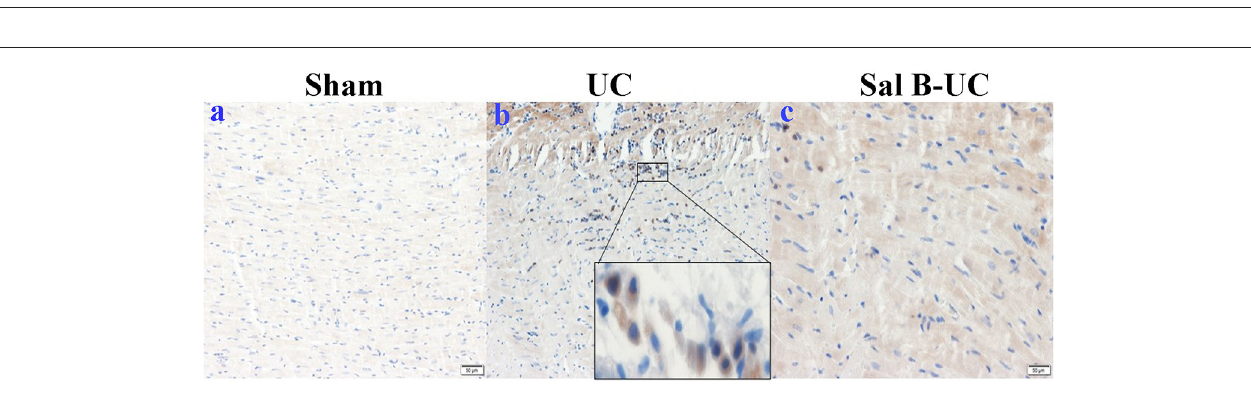
FIGURE 5 | Immunohistochemical (IHC) staining of CD3. The IHC staining of CD3 in the sham, UC, and Sal B-UC groups. CD3-T-lymphocytes were not recognized in the sham group (A). The number of CD3 infiltrations (brown color) was significantly increased in the UC group (B). A limited number of CD3 + was observed in the Sal B-UC group (C)